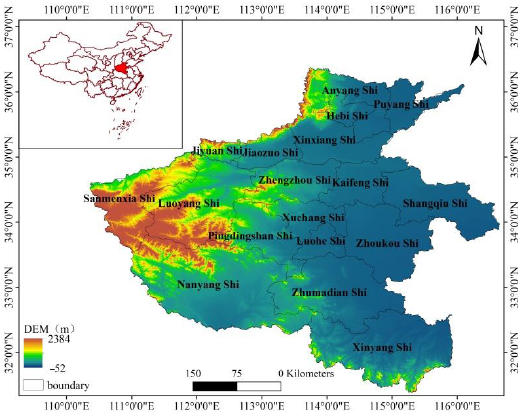
Figure 1. The location of the study area.